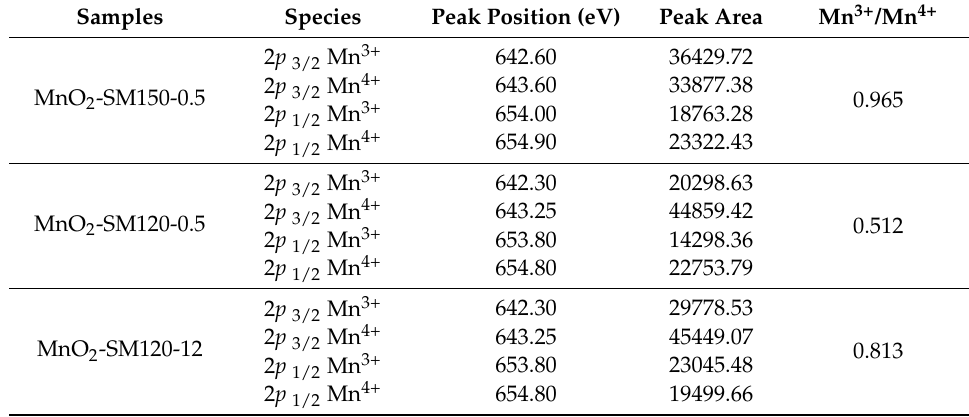
Figure 3. XPS spectra of Mn 2 p for MnO 2 -SM120-12 ( a ); MnO 2 -SM120-0.5 ( b ); MnO 2 -SM150-0.5 ( c ); and the Mn 3+ /Mn 4+ values of the three samples ( d ). Table 1. The XPS dates of Mn 2 p for MnO 2 -SM120-12; MnO 2 -SM120-0.5; MnO 2 -SM150-0.5; and the corresponding perk areas and Mn 3+ /Mn 4+